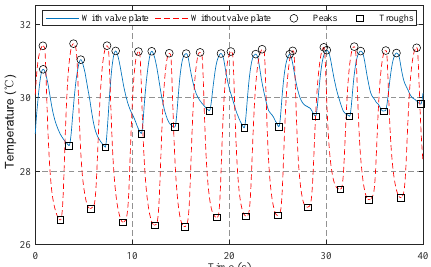
Figure 2. The measured temperatures at the vent hole of